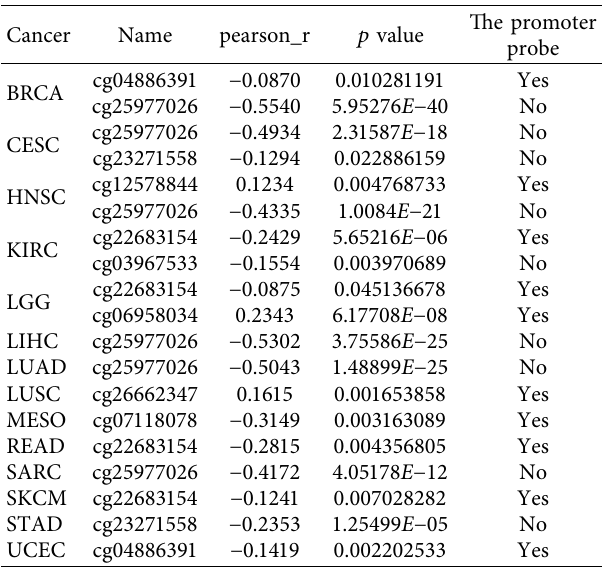
Figure 2: KDM1A mutations in different tumors according to the TCGA data. (a) The alteration frequency of KDM1A with mutation type using the cBioPortal tool. (b) KDM1A mutation site and corresponding diseases of the highest number of cases are displayed. (c) The top three mutation sites including R321C/H, E477K, and R591 ∗ /L showed in the 3D structure of KDM1A. (d) Mutation status of KDM1A was relevant to the OS, PFS, DSS, and DFS of breast cancer analyzed by the cBioPortal tool. (e) Breast cancer samples with KDM1A mutation were identified from the TCGA Invasive Breast Carcinoma data set. Table 2: Relationship between KDM1A DNA methylation and gene